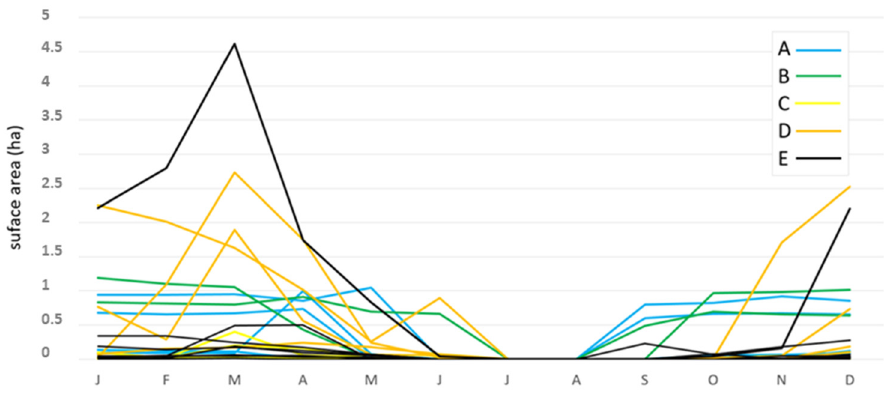
Figure 5. Surface size variation (in ha) of the monitored Mediterranean temporary ponds during the study period. The monitored coastal ponds are grouped as indicated in Figure 1: A, pastures; B, agricultural with grasses; C, reserves; D, urban; E, mixed agricultural and pastures.